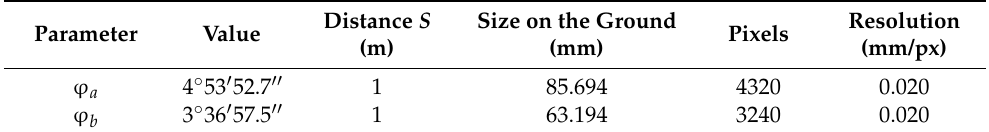
Table 1. The results of resolution